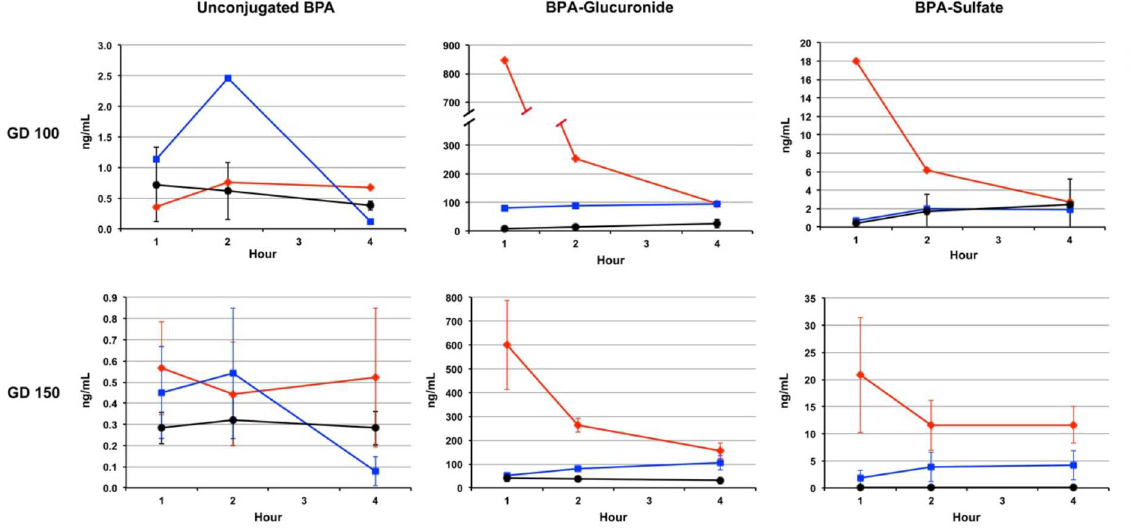
Fig 1. Levels of unconjugated BPA, BPA-G and BPA-S in maternal (red line) and fetal (blue) serum and amniotic fluid (black) at 100 (top panel, N = 2) and 150 days gestation (bottom panel, N = 3) following a single oral dose of